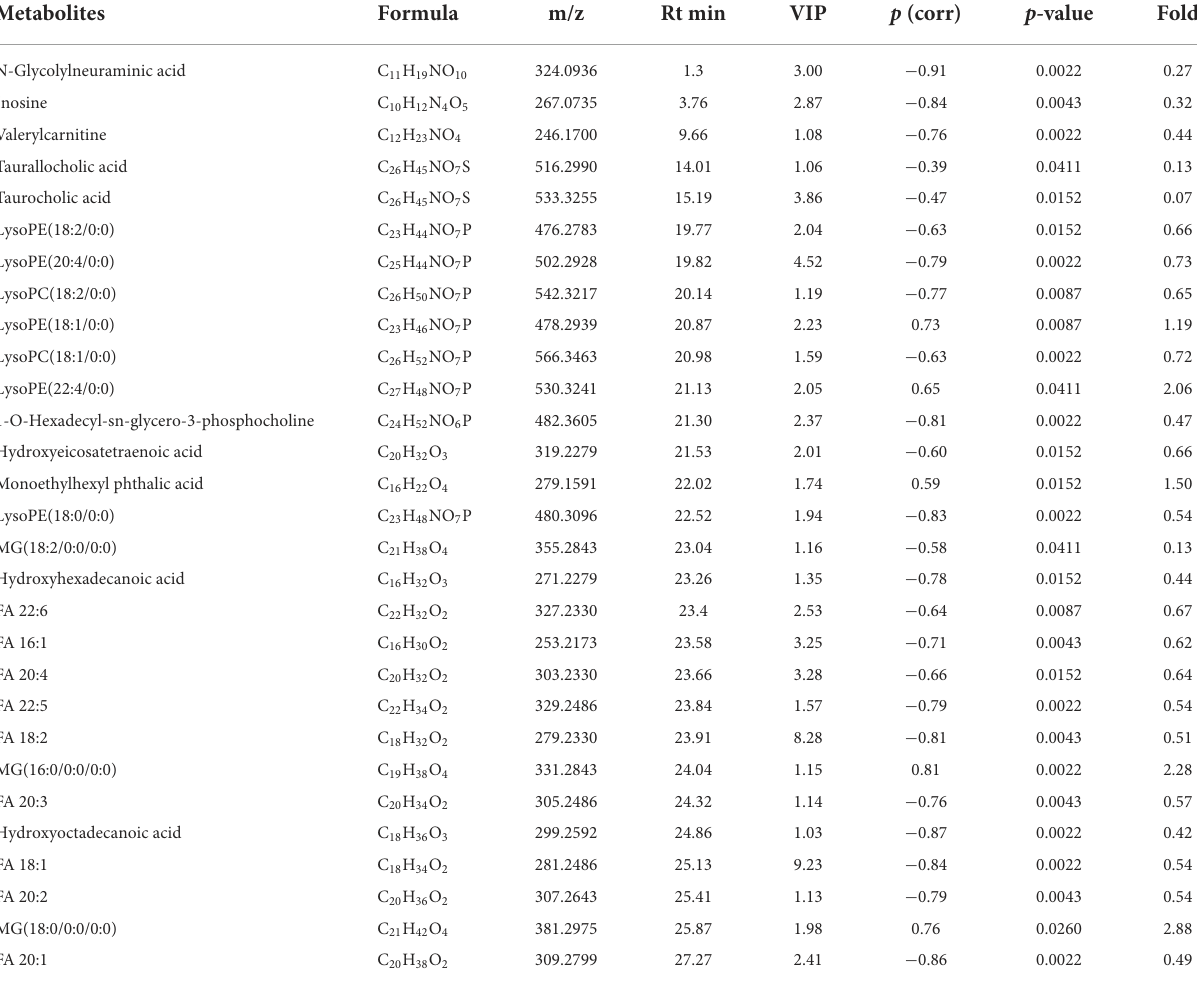
TABLE 1 Basic information of differential metabolites in Control vs.